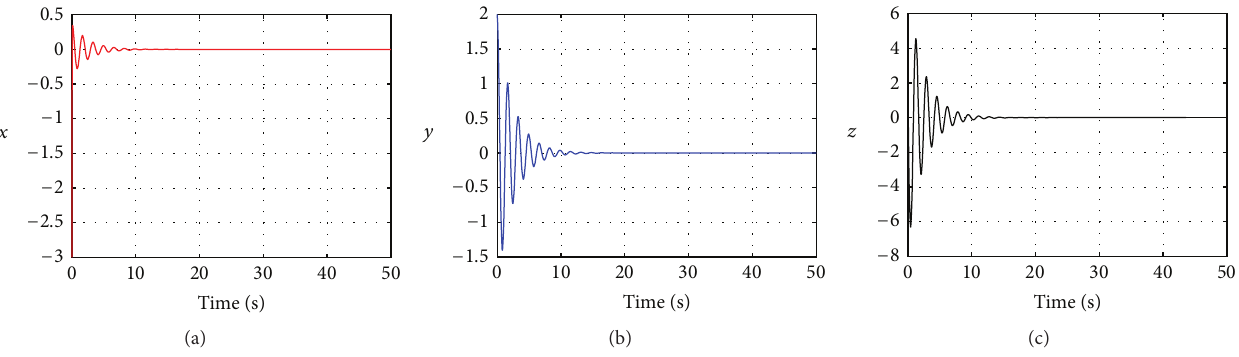
Figure 2: The asymptotic stability of 𝑆 0 with controller (28).